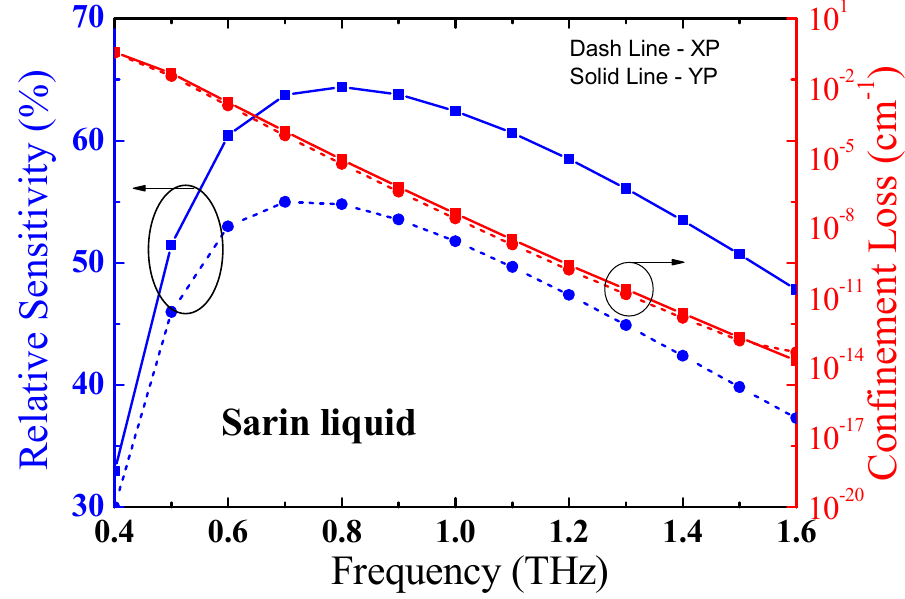
Figure 12. Relative sensitivity and confinement loss of the proposed sensor when the QE air holes were filled with sarin liquid.